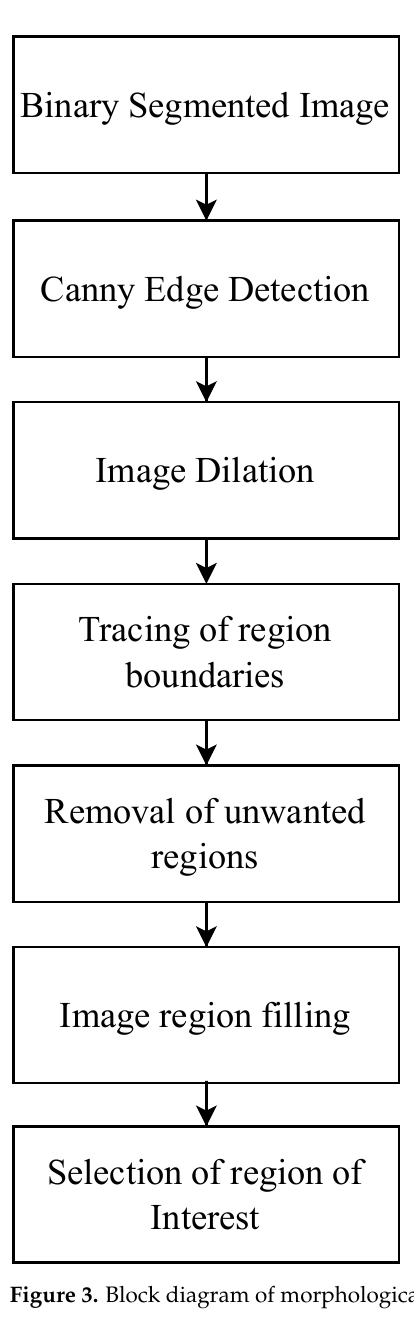
Figure 3. Block diagram of morphological based